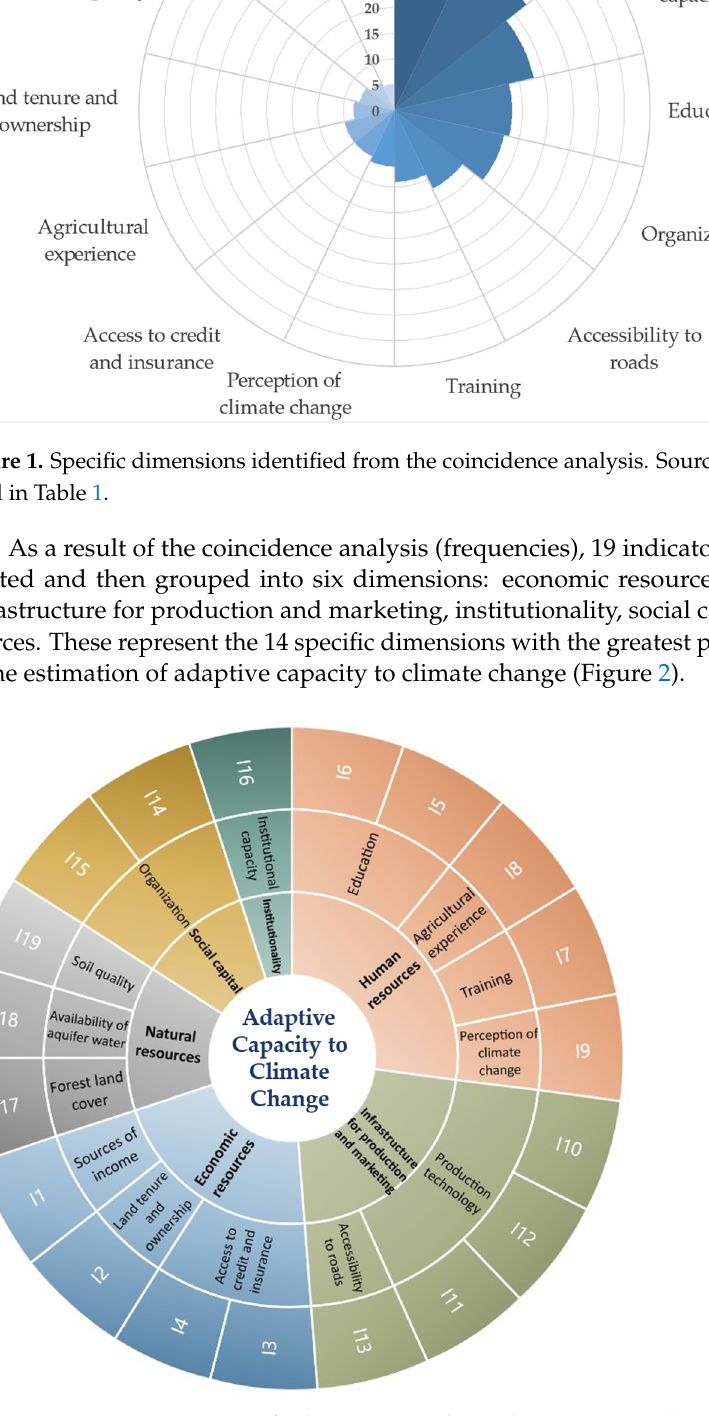
Figure 2. 6 Dimensions, 14 Specific dimensions and 19 Indicators, grouped together. Source: Prepared by the authors.